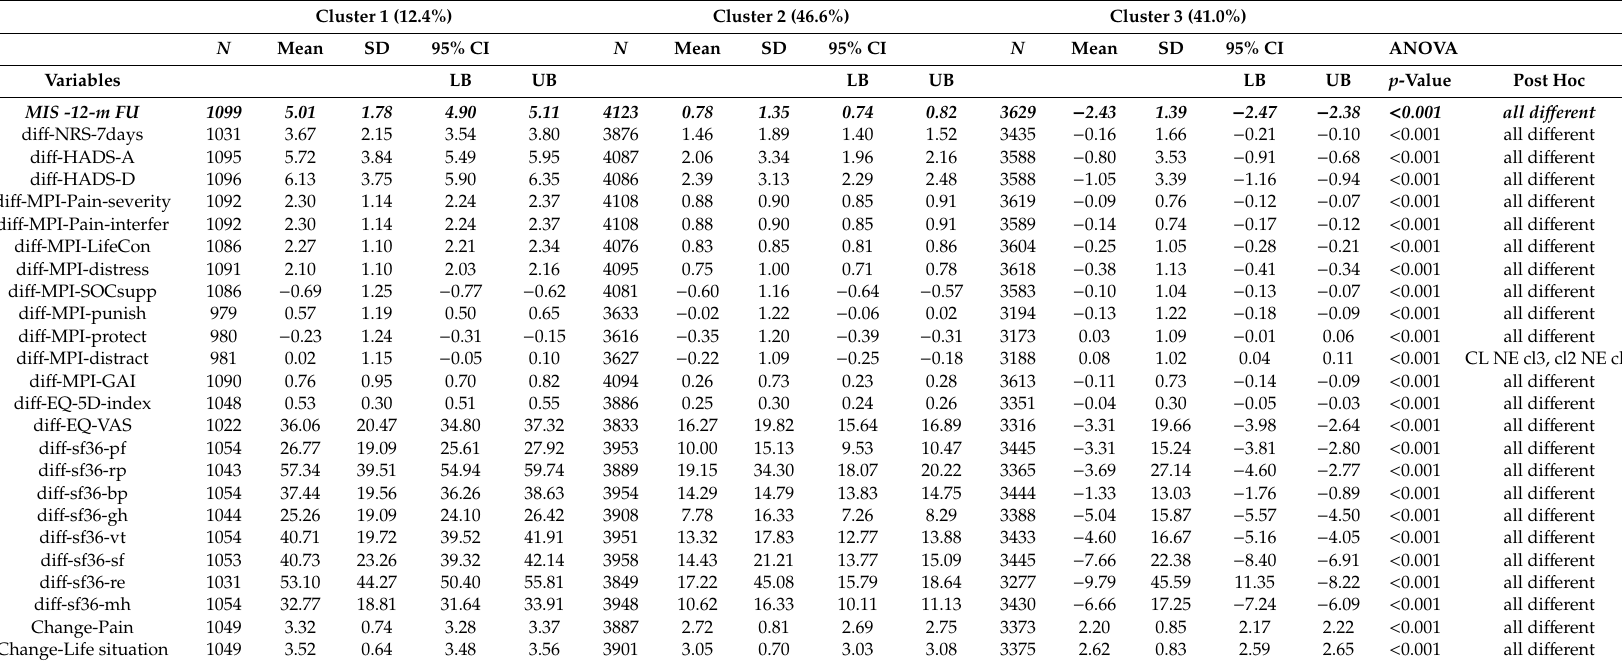
Table 7. Clusters from HCA based on MIS ( t -scores) of the first component of the PCA for the changes in outcomes from pre-IMMRP to 12-month FU (denoted as MIS 12-m FU ). To facilitate understanding, the changes for all the outcomes are shown (mean, SD, and 95% confidence interval). The two bottom rows show the estimations of changes (not included in PCA and the calculation of